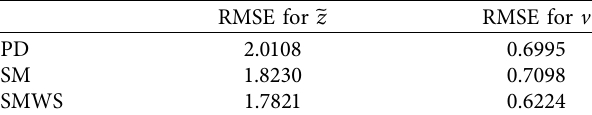
Table 6: Comparisons for the second electricity